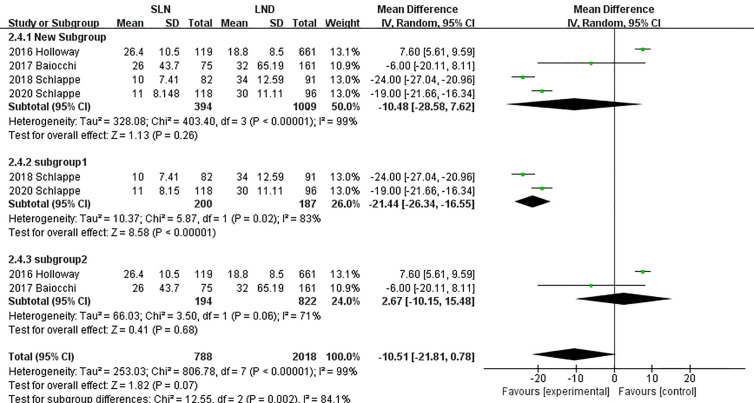
Meta-analysis of pelvic lymph nodes removed.